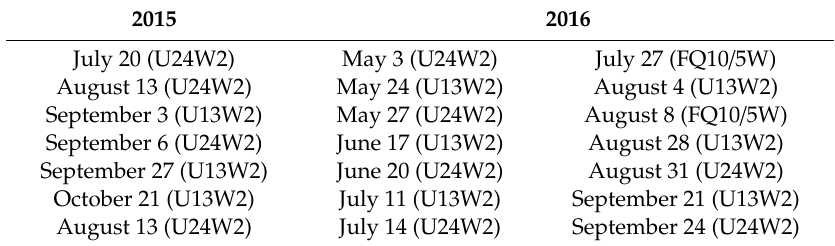
Table 2. SAR acquisition dates of Wide Ultra-Fine (U13W2 and U24W2) and Wide Fine-Quad (FQ10 / 5W) beam modes over URSA for 2015 and 2016.